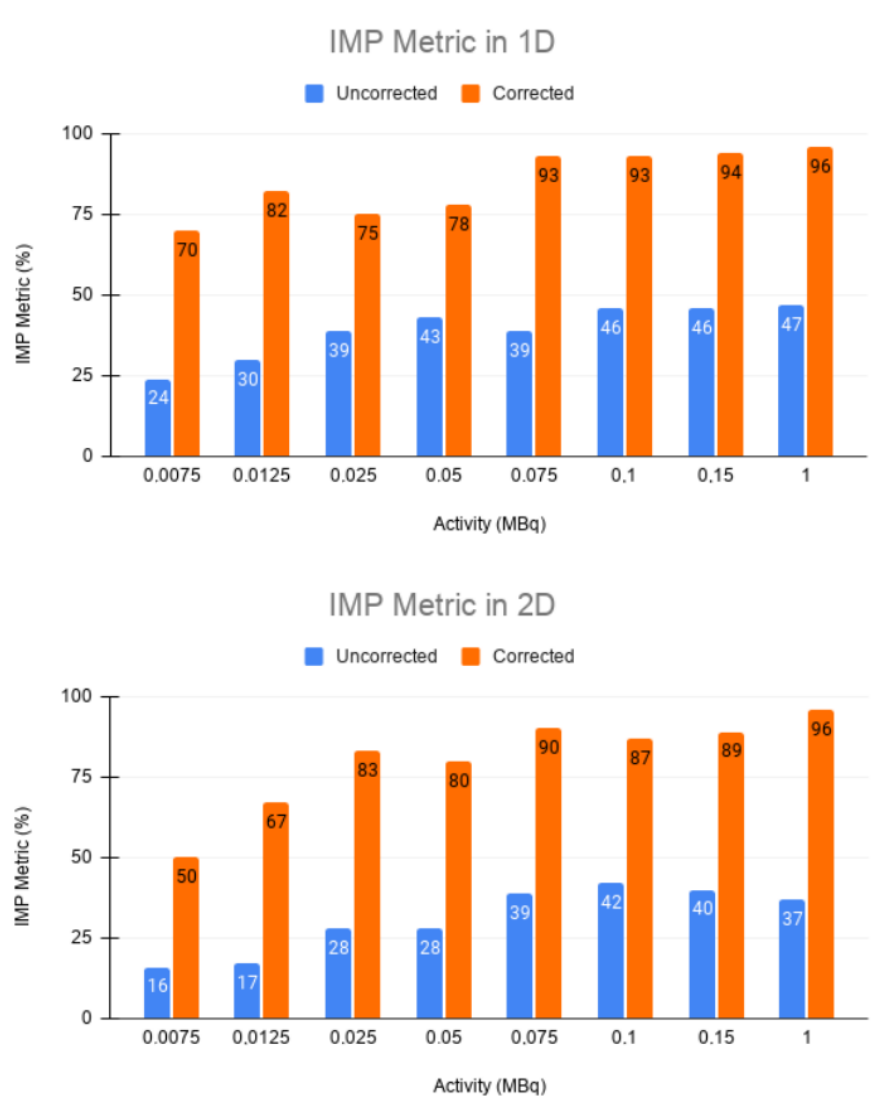
Figure 8. Precision of coincidence in intensities (IMP) metric values for 1D ( top ) and 2D ( bottom ) for static-uncorrected and static-corrected image